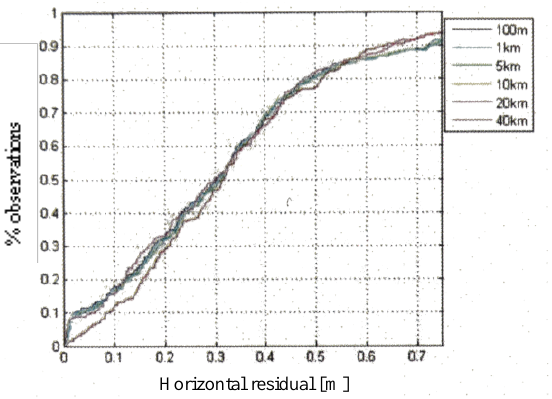
Figure 6. Horizontal residual vs % – u-blox 5T – 5 minutes